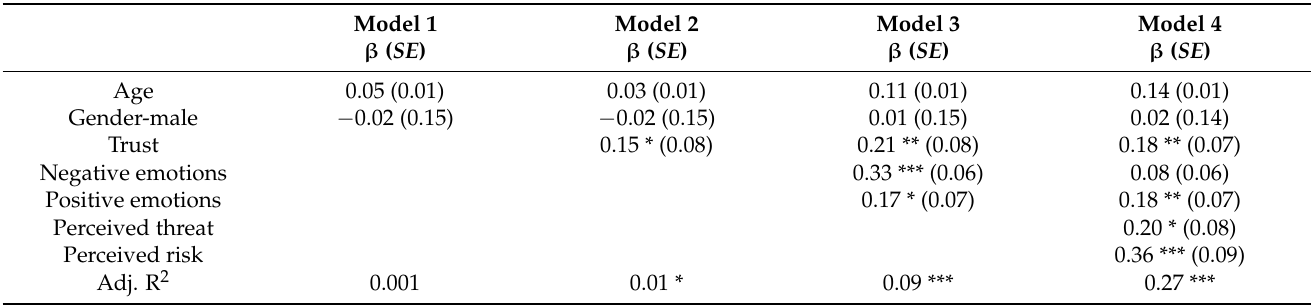
Table 4. Multiple hierarchical regression for compliance with trust, emotions, perceived threat, and perceived risk as variables ( N =